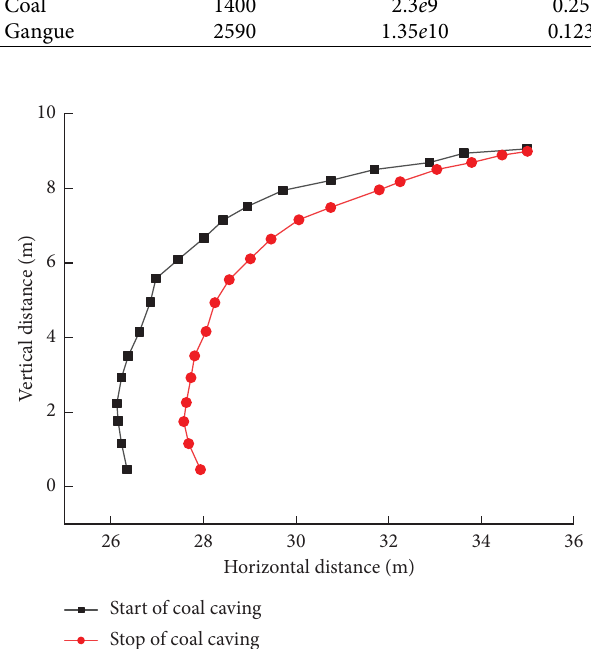
Figure 3: Te coal gangue boundary line before and after coal